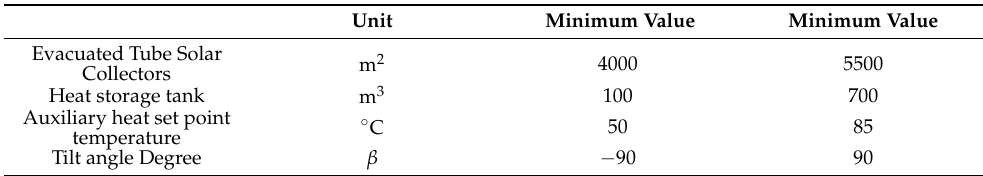
Table 5. Parameters and ranges for the parametric study.